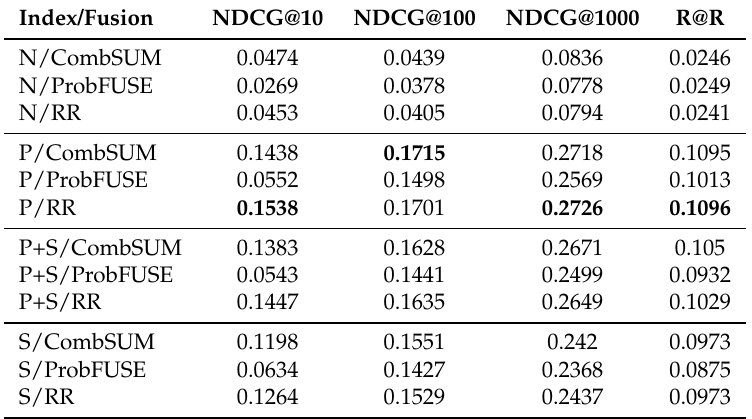
Table 11. T1: NDCG and Recall@R for the fusion runs. The highest values are in bold.